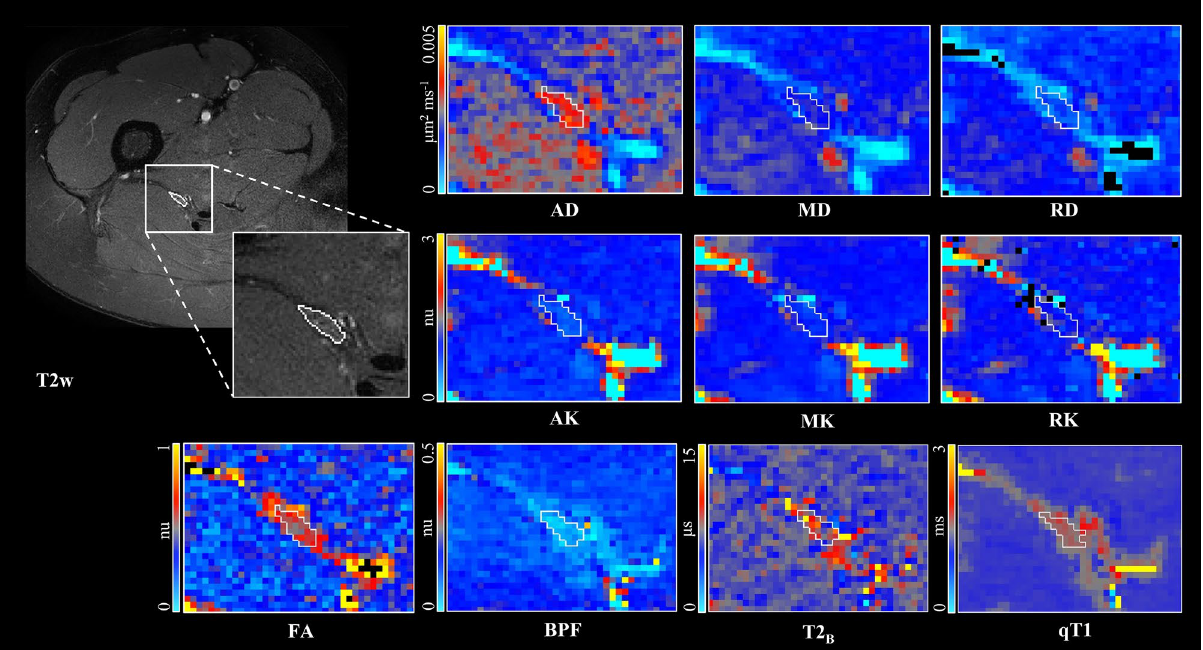
Figure 3. Example maps of standard diffusion tensor (DTI) derived metrics axial/radial/mean diffusivity (AD/RD/MD) and fractional anisotropy (FA), diffusion kurtosis imaging (DKI) metrics axial/radial/mean kurtosis (AK/RK/MK), quantitative magnetisation transfer (qMT) metrics bound pool fraction and bound pool transverse relaxation time (BPF/T2 B ) and quantitative longitudinal relaxation time (qT1), in the sciatic nerve of a healthy